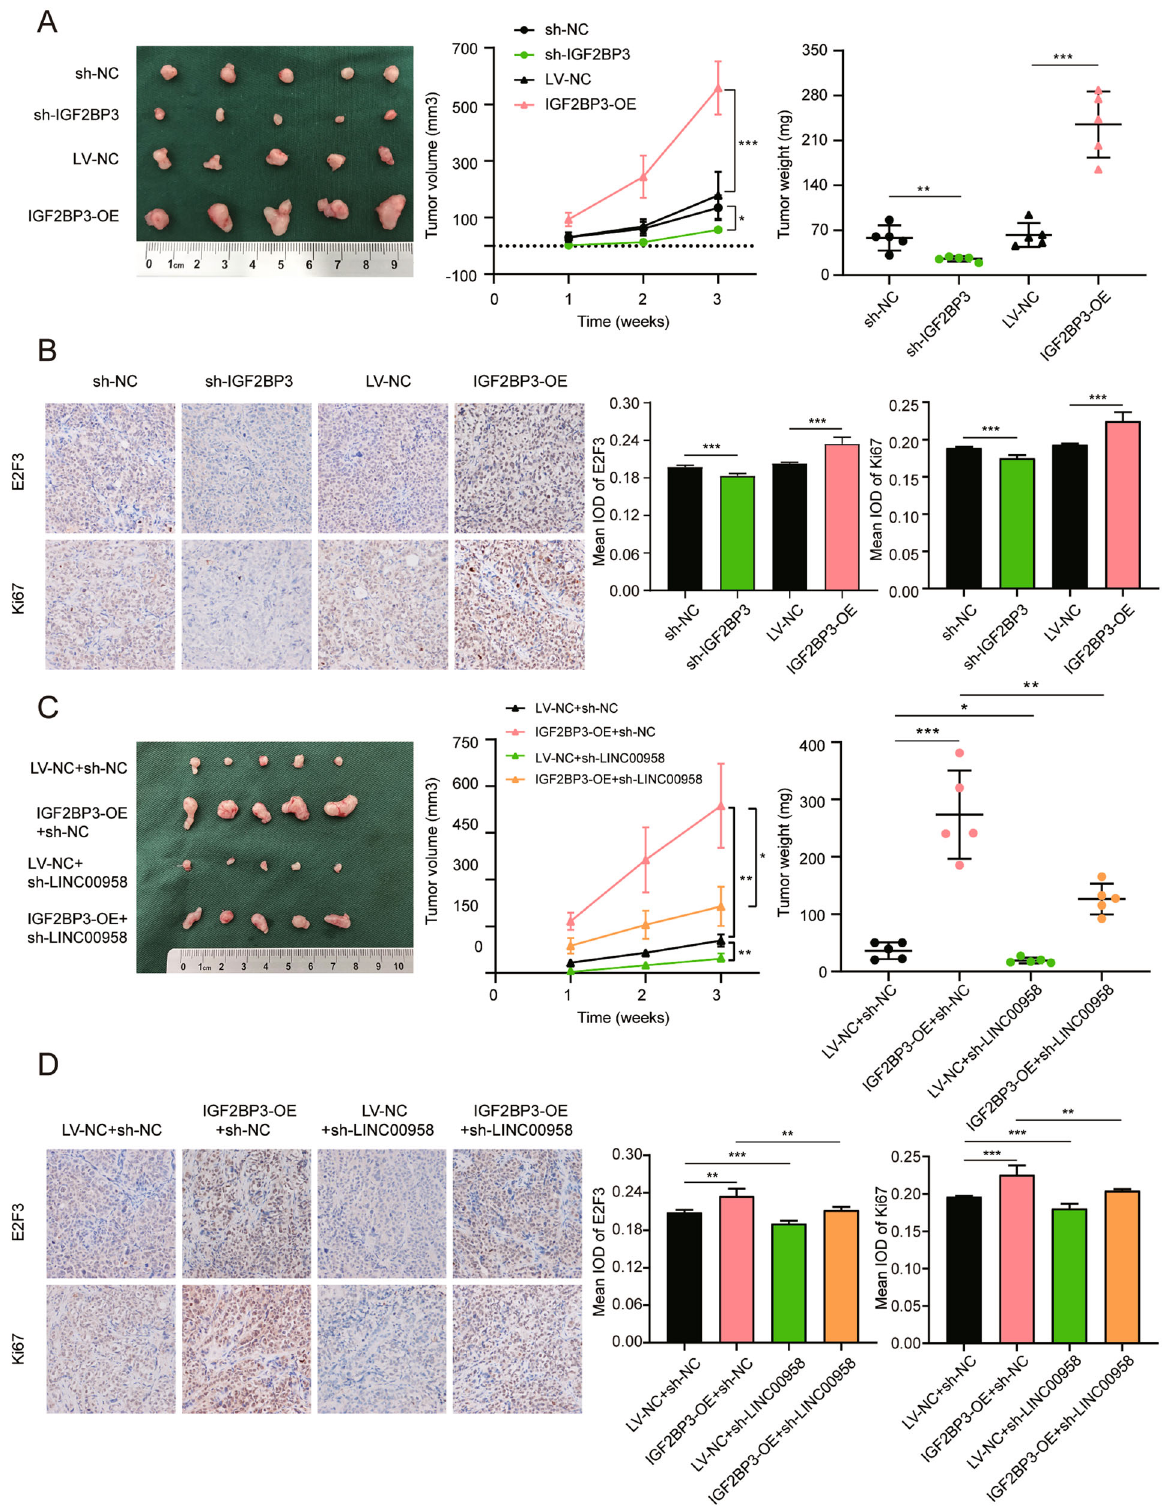
Fig. 7 IGF2BP3 could promote EC cells growth in vivo. A , C Representative pictures (left), the growth curve in vivo (middle), and the weight at the endpoints (right) of xenograft tumors in nude mice ( n = 5 per group). B , D Representative images and quanti fi cation results of immunohistochemistry staining of xenograft tumors were used to display the expression of E2F3 and Ki67 (× 200). * P < 0.05, ** P < 0.01, *** P < 0.001. Data, mean ± S.D.